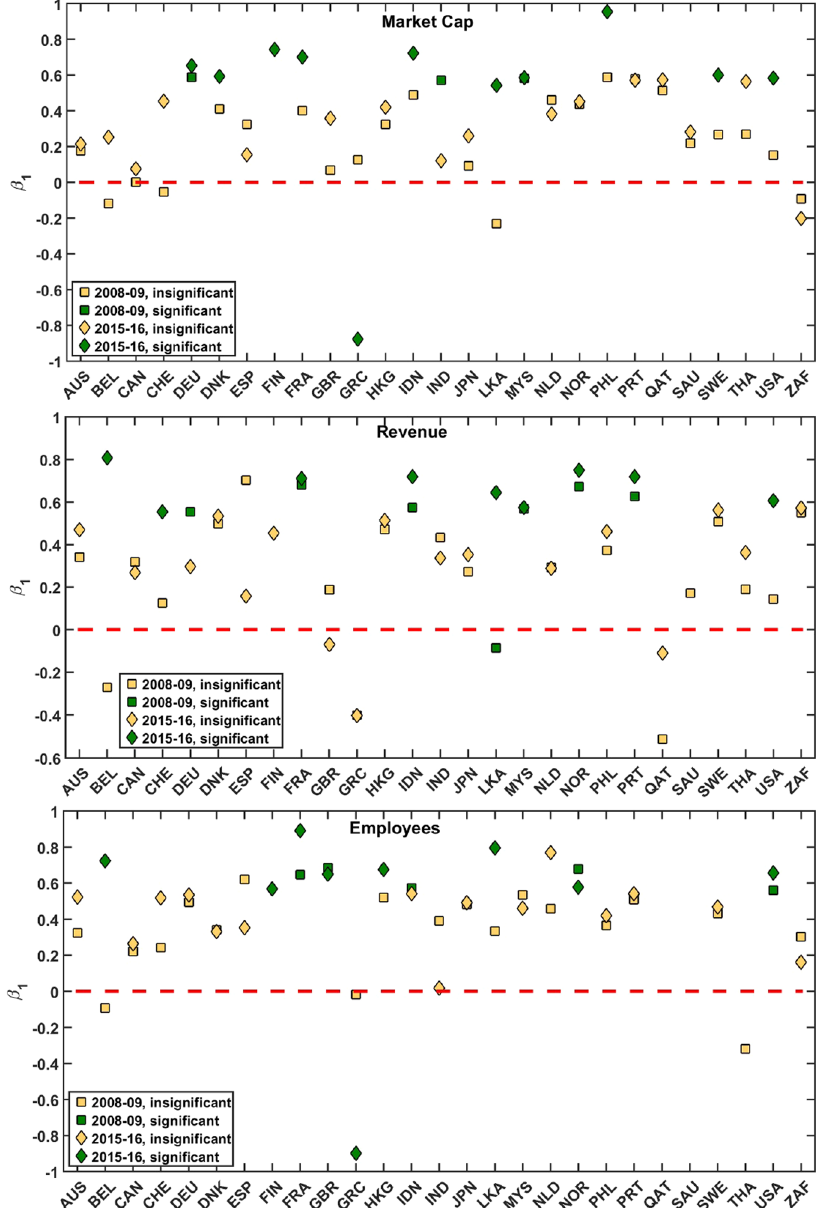
Figure 6. Comparison of the regression results (estimates of β 1 using Eq. 1) to explain variation in the sectoral eigenvector centralities by the variation in sector-level macro data. Upper : market capitalization, Middle : Revenue, Lower : Employees, for the years 2008–09 and 2015–16. Detailed estimation results are given in the Supplementary Information Tables